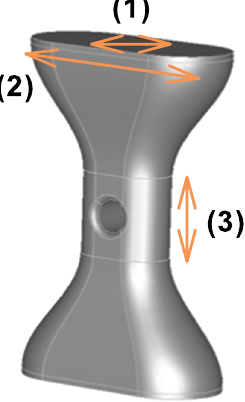
FIG. 2. CST MICROWAVE STUDIO (cid:1) (MWS) view of a racetrack- shaped spoke. (1) base or aperture width, (2) base or aperture length, (3) aperture